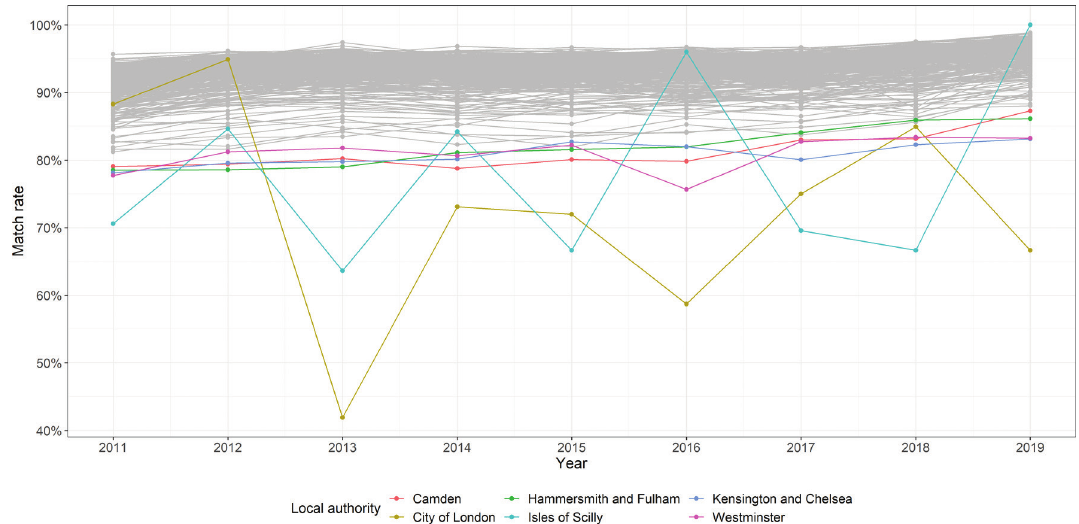
Figure 7 Match rate across local authority in England and Wales,